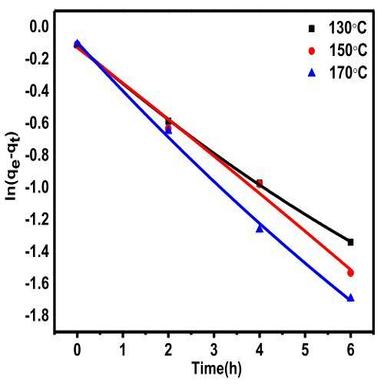
Pseudo 1st order kinetic model: plot of time vs. ln(qe – qt).